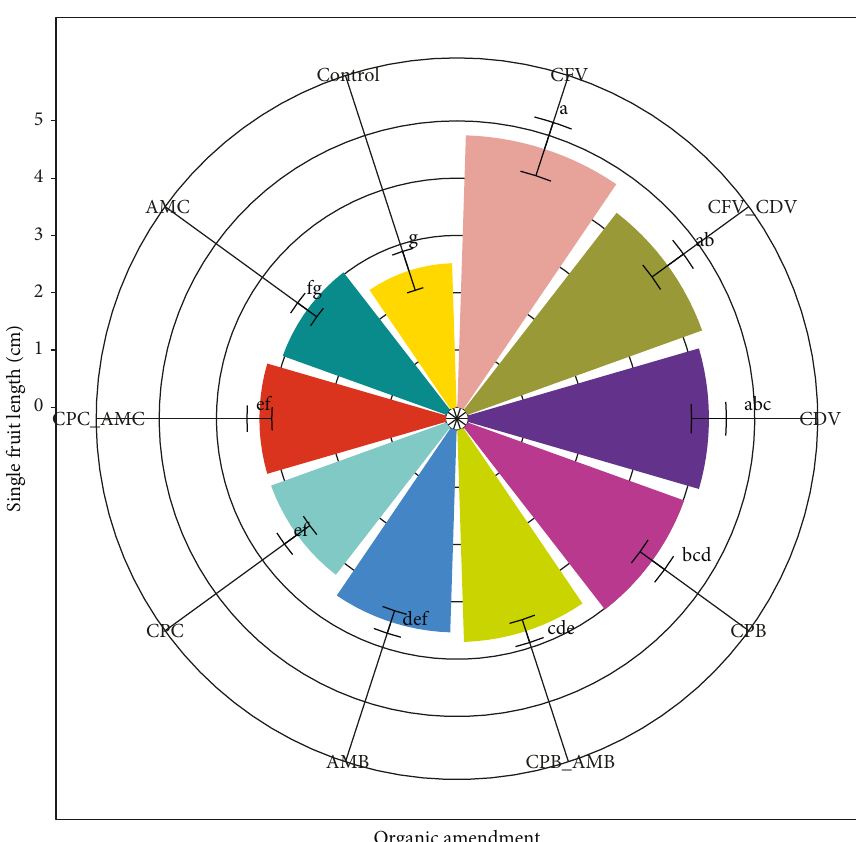
Figure 10: Response of hot pepper single fruit length to different organic amendments.